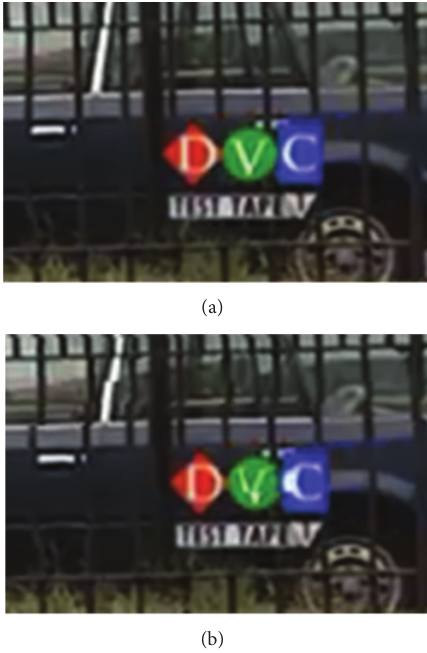
Figure 16: Effect of decrease on SSIM by 0.0506.